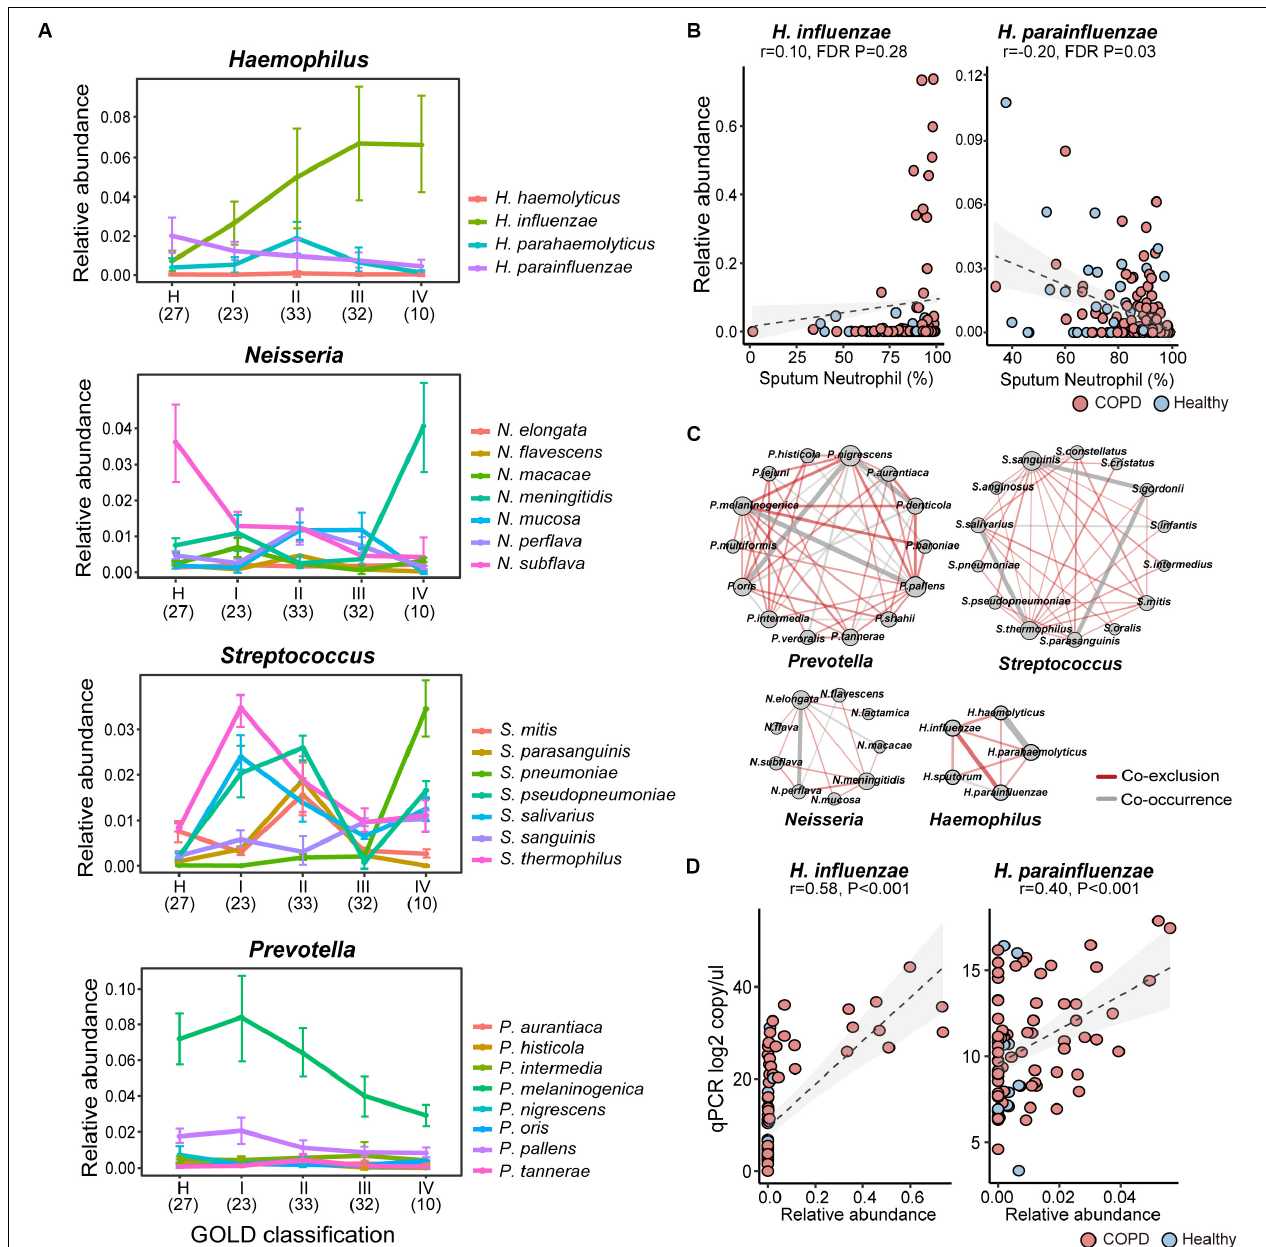
FIGURE 2 | The intra-genus heterogeneity of the airway microbiome. (A) The alternation of major species in Haemophilus , Neisseria , Streptococcus, and Prevotella between healthy controls and COPD patients with increasing disease severity based on GOLD classification (spirometry-based). The average relative abundance and standard deviation of each species in each group were shown. The number of subjects in each subgroup was indicated in the parenthesis. (B) The reciprocal relationship between H. influenzae and H. parainfluenzae with sputum neutrophilic percentage. (C) The species-level co-occurrence network showed more pervasive co-exclusive than co-occurrence relationships between major species-level taxa within Prevotella , Streptococcus , Neisseria and Haemophilus . Each node represents a species-level taxon and each edge represents a correlation between paired taxa. Only significant correlations were shown in the networks (SparCC, P < 0.05). The size of the node is proportional to its degree of connectivity. The width of the edge is proportional to the absolute correlation coefficient. Co-exclusion relationships were colored in red, whereas co-occurrence relationships were colored in gray. (D) qPCR assays using species-specific primers showed concordance between absolute counts and relative abundances of H. influenzae and H. parainfluenzae